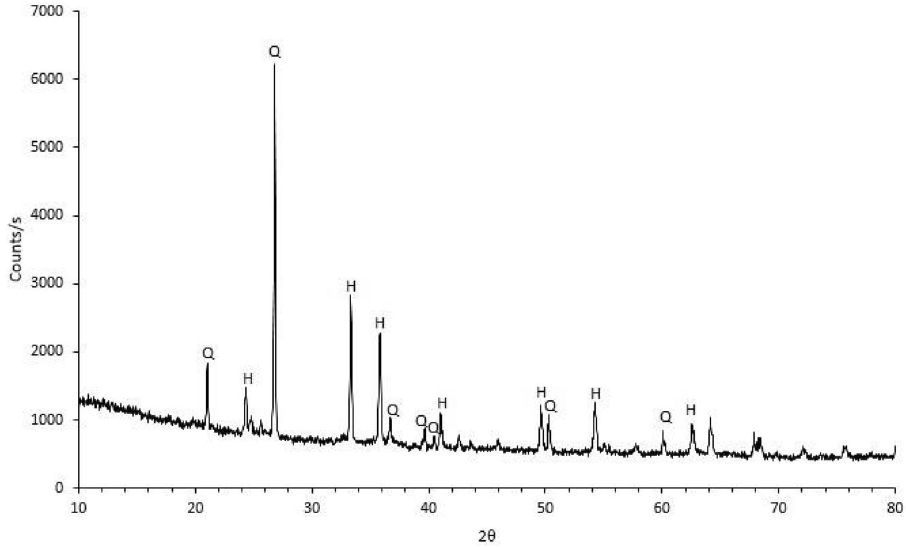
Fig. 8 Mineralogical analysis of MT after thermal treatment